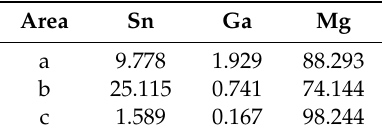
Table 2. The chemical compositions of the areas marked by the white rectangles in Figure 1f using the wavelength dispersive spectrometer (WDS) (in wt